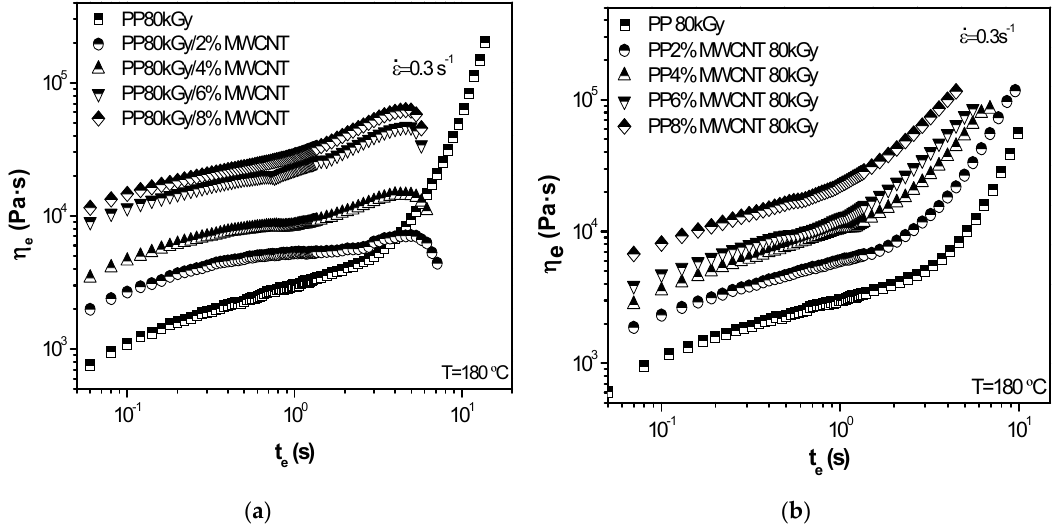
Figure 5. ( a ) Elongational viscosity vs. elongation time for the samples elaborated with Protocol A; ( b ) elongational viscosity vs. elongation time for the samples elaborated with Protocol B. Irradiated pure PP is also included for comparison purposes.